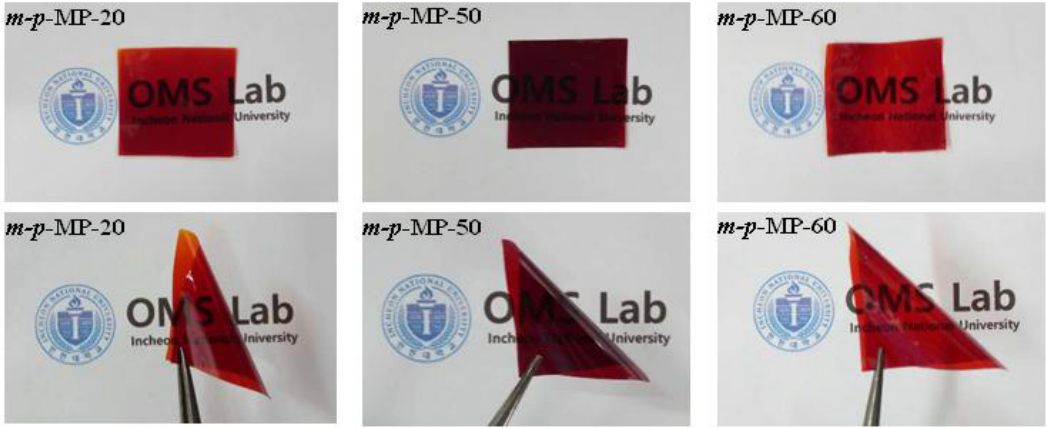
Figure 2. Photographs of the m-p -MP-20, m-p -MP-50, and m-p -MP-60 copolymer membranes.